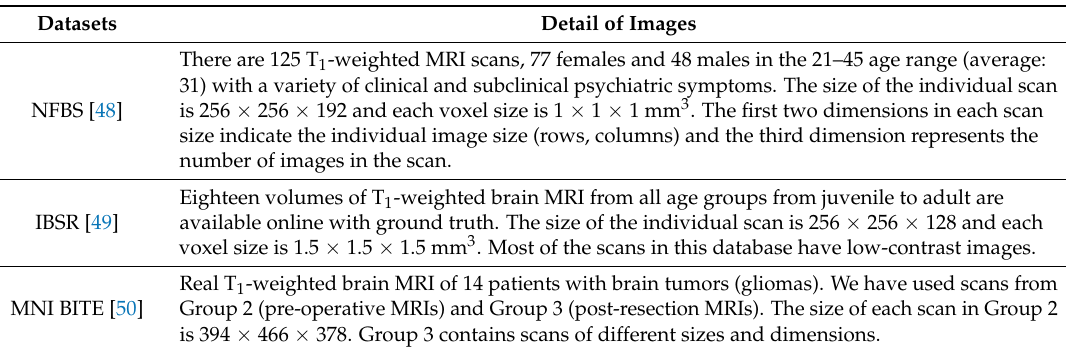
Table 1. Datasets used for